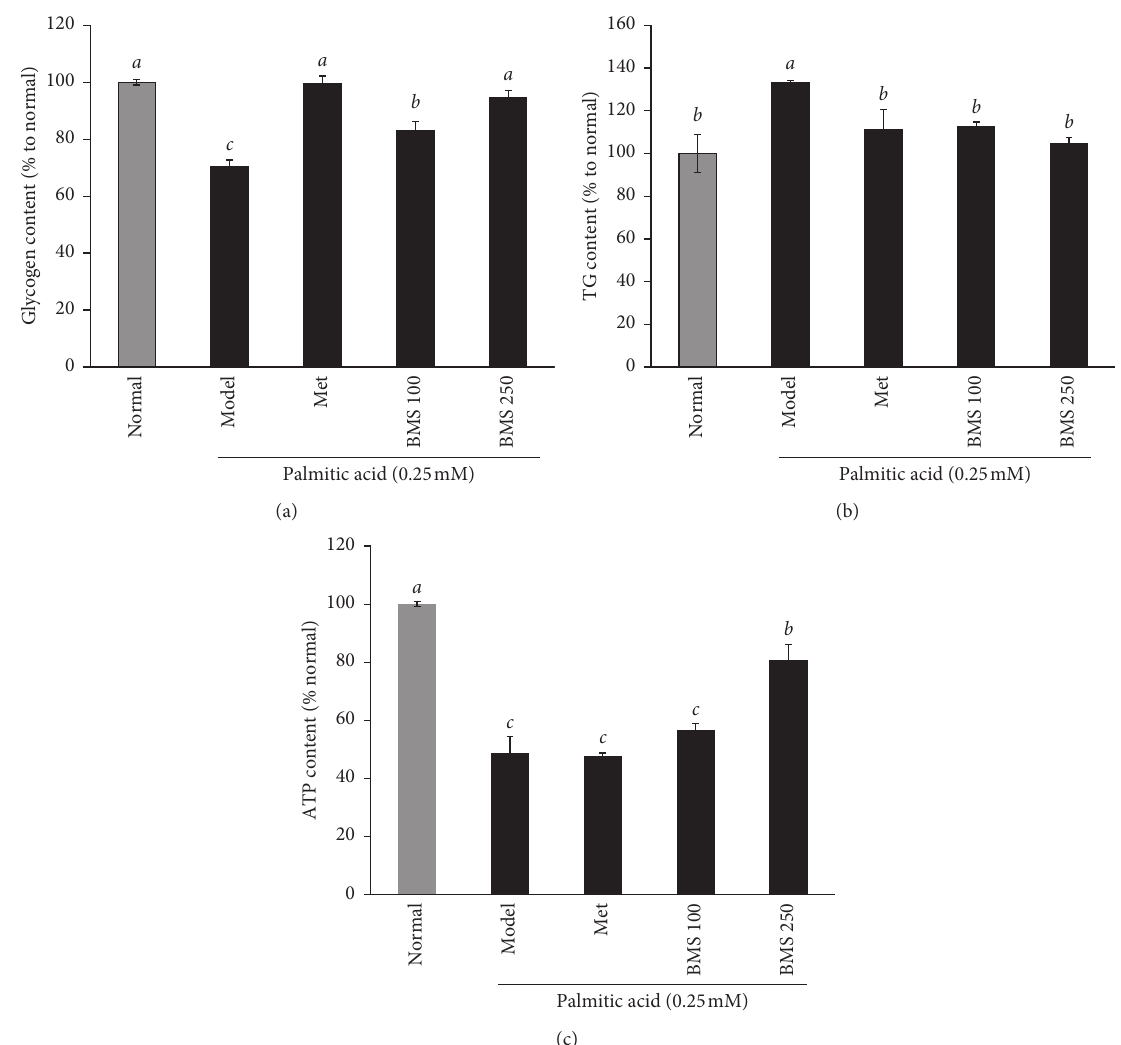
Figure 2: Effect of BMS on the levels of glycogen (a), TG (b), and ATP (c) of HepG2-IR cells. Values are expressed as means ± SE. Statistical analysis was performed using ANOVA. Different superscripts were considered significantly different. HepG2-IR cells: HepG2 insulin resistance cells; TG: triglyceride; Met: metformin; BMS: bitter melon